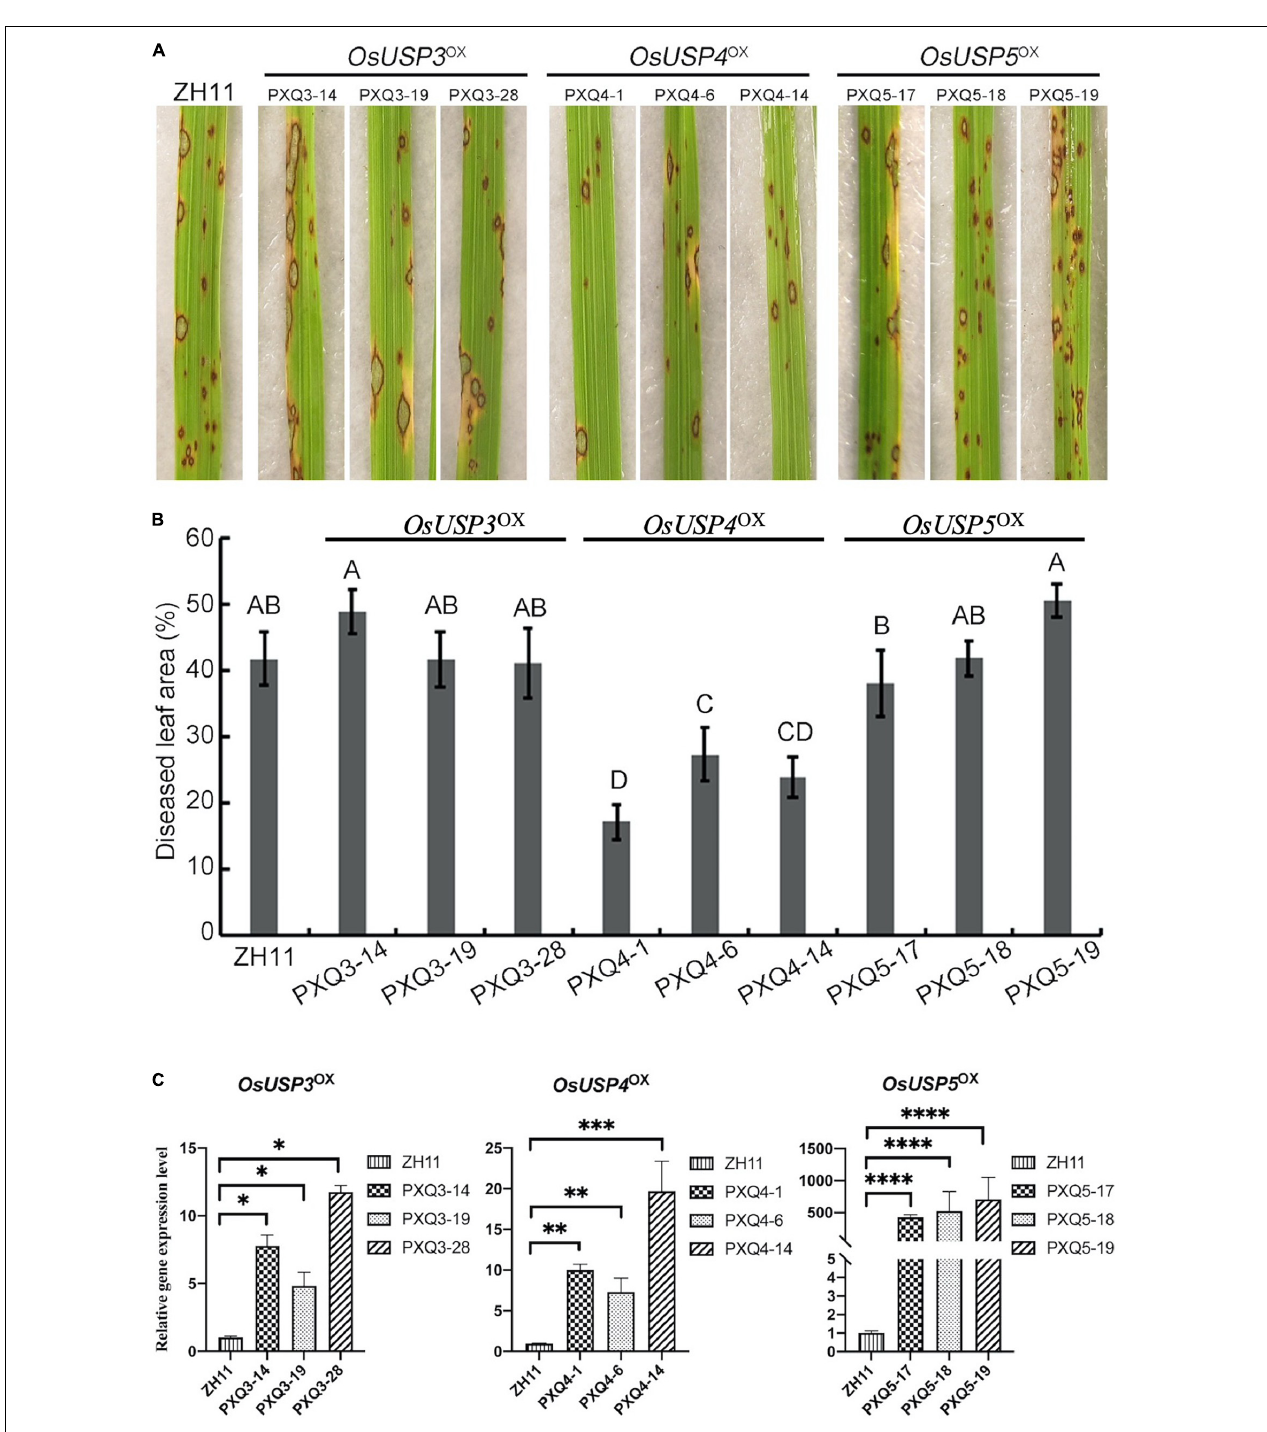
FIGURE 6 | Disease reactions of ZH11, OsUSP3 OX , OsUSP4 OX , OsUSP5 OX leaves incubated by Guy11. (A) Photographs showing disease reaction of indicated rice lines and races: wild-type (ZH11); overexpression transgenic line of OsUSP3 OX (PXQ3-14, PXQ3-19, PXQ3-28), OsUSP4 OX (PXQ4-1, PXQ4-6, and PXQ4-14), and OsUSP5 OX (PXQ5-17, PXQ5-18, PXQ5-19). (B) Disease lesion area was assessed by Image J. Lesions were photographed and measured or scored at 6 days post-inoculation by isolation of Guy11. A, B, C, and D represent the significant difference (one-way ANOVA test, P < 0.01). (C) qRT-PCR was used for expression-level evaluation of universal stress proteins (USPs) coding genes in ZH11 and corresponding transgenic lines: OsUSP3 in PXQ3-14, PXQ3-19, and PXQ3-28; OsUSP4 in PXQ4-1, PXQ4-6 and PXQ4-14; OsUSP5 in PXQ5-17, PXQ5-18, and PXQ5-19. T -test Asterisks denote significant differences compared to ZH11 plants (Student t -test with two-sided and three replicates, ∗ P < 0.05; ∗∗ P < 0.01; ∗∗∗ P < 0.001; ∗∗∗∗ P < 0.0001).